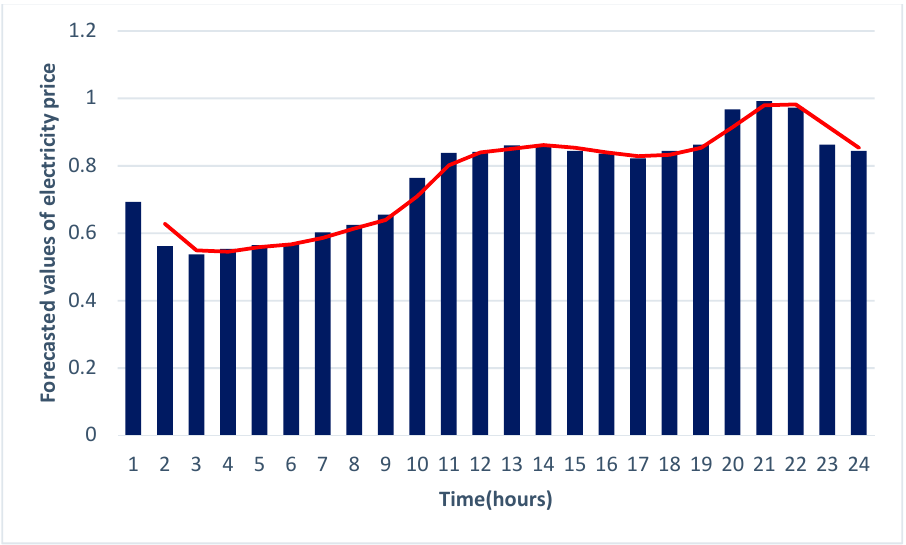
Figure 5. Default load demand curve.